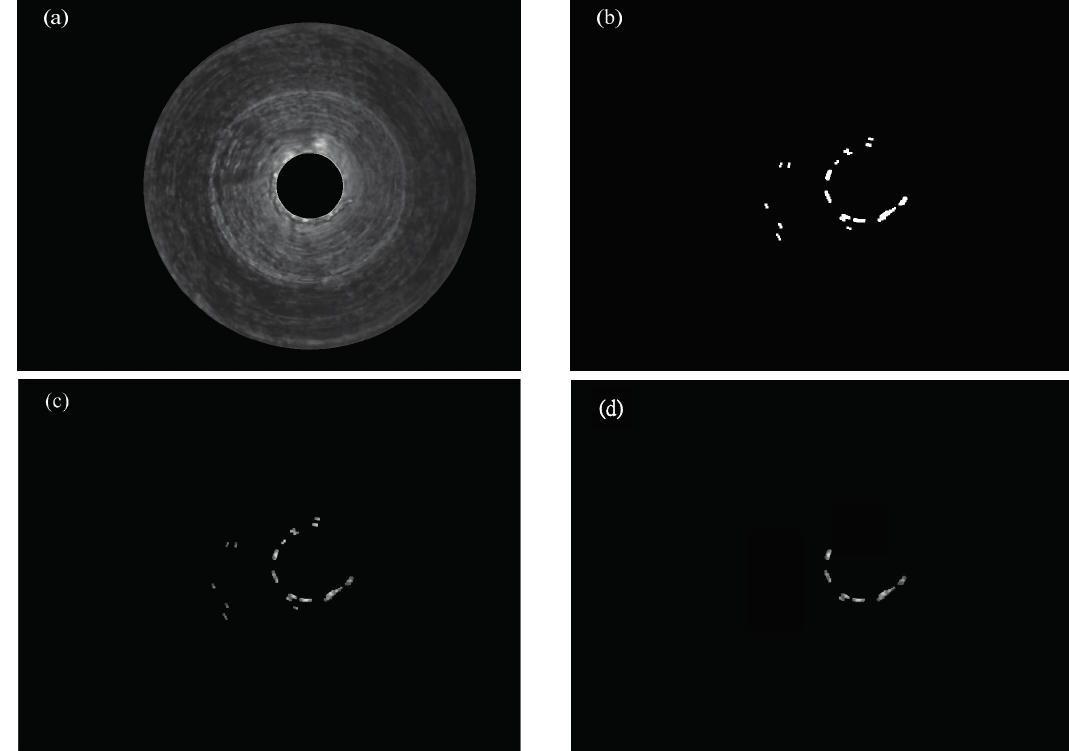
Figure 13. ( a ) Original image; ( b ) segmented binary image after the CI algorithm; ( c ) segmented image after the CI algorithm; ( d ) classification